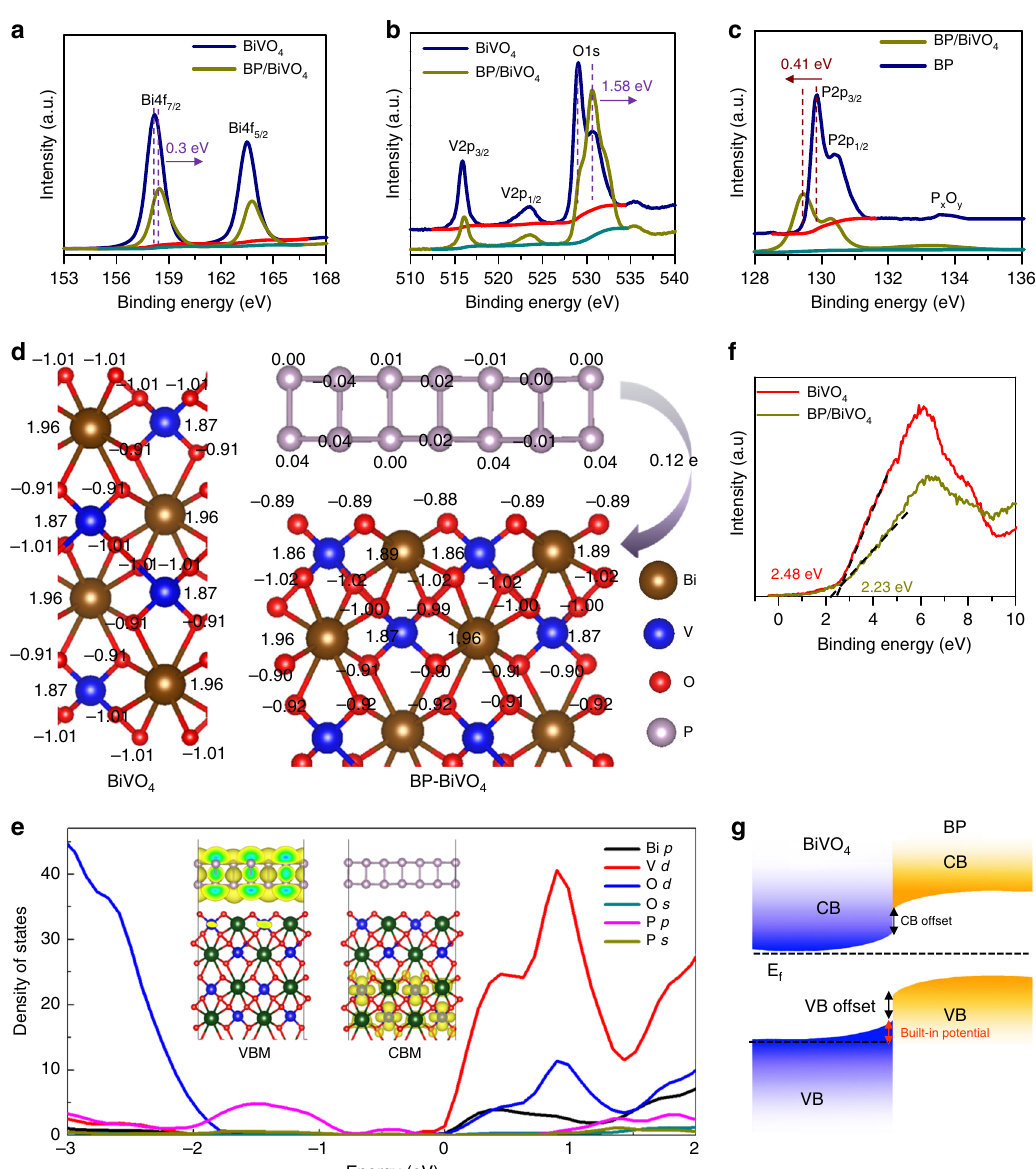
Fig. 2 Electronic structure characterizations. a Bi 4 f , ( b ) V 2 p and O 1 s XPS of BiVO 4 and BP/BiVO 4 photoanodes, ( c ) P 2 p XPS of BP and BP/BiVO 4 photoanode, d The charge density difference between BiVO 4 and BP/BiVO 4 , ( e ) VB XPS of BiVO 4 and BP/BiVO 4 photoanodes, ( f ) DOS of BP/BiVO 4 heterojunction, ( g ) Energy diagram of BP/BiVO 4 heterojunction